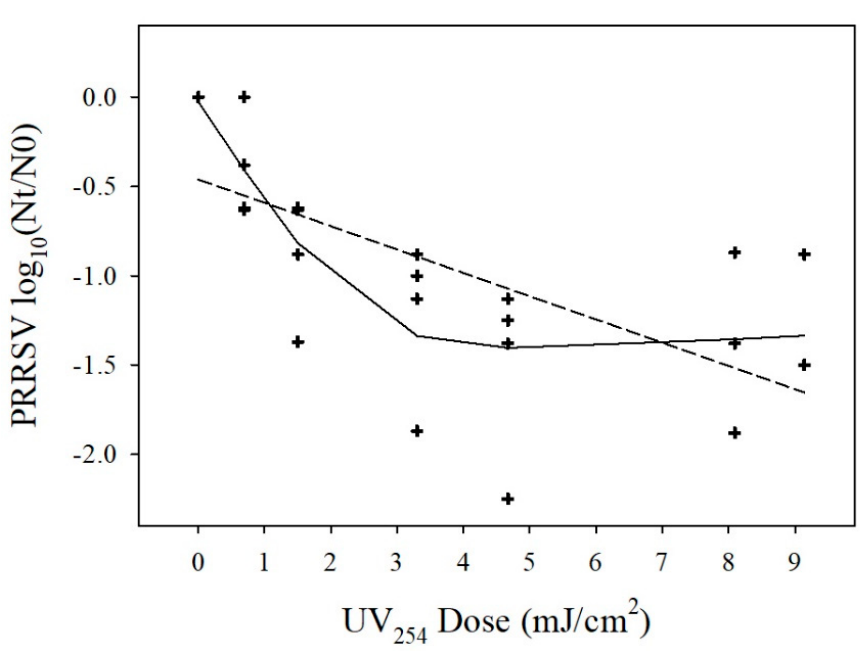
Figure A1. UV-A (254 nm) treatment inactivation curve on aerosolized PRRSV. One-stage (dashed line) and two-stage (solid line) inactivation curves were drawn. PRRSV survival is expressed as log 10 (N t /N 0 ), not as a percentage (%) as shown in Figure 2. In Appendix A, the UV222 dose (mJ/cm 2 , horizontal axis values) in Figure A2 needs to be corrected.